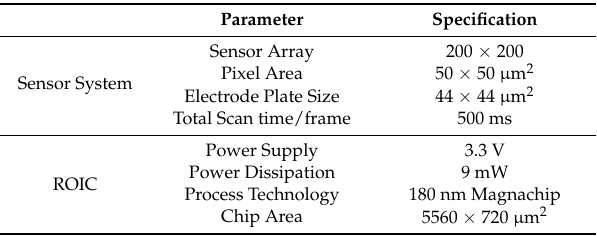
Table 5. Specification of the fingerprint sensing system.